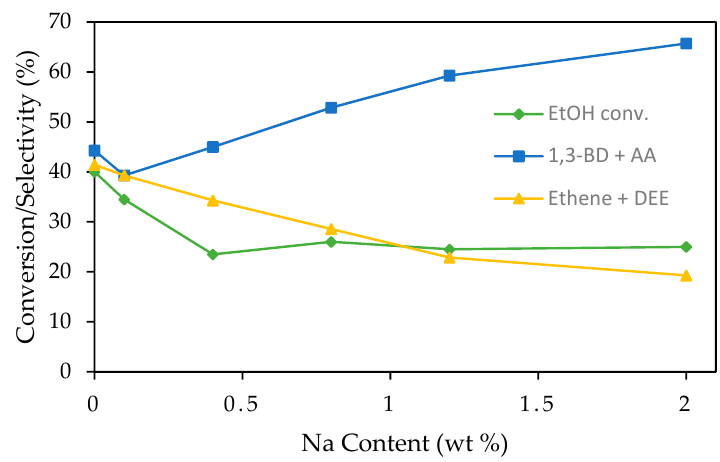
Figure 8. Effect of catalyst Na content on ethanol conversion and selectivity towards the main categories of products ( T = 648 K, weight hourly space velocity of ethanol ( WHSV ) = 0.62 h − 1 , time on stream ( TOS ) = 3 h). Reprinted with permission from [30]. Copyright 2016, John Wiley and Sons.